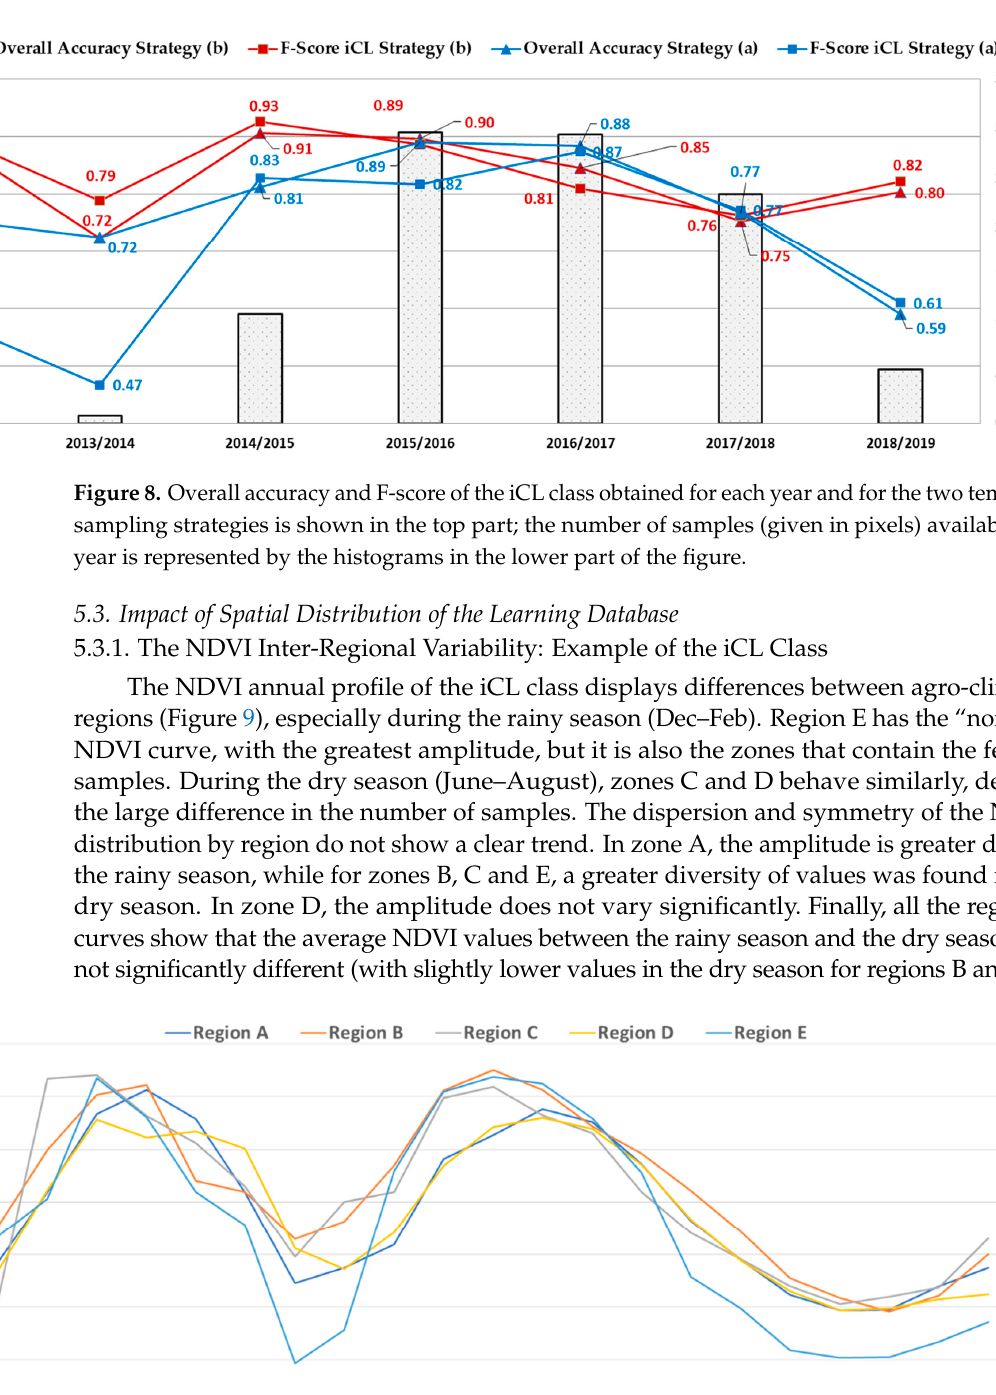
produced in previous and mid ‐ 2019) of the iCL class samples over the five agro ‐ climatic regions of Mato